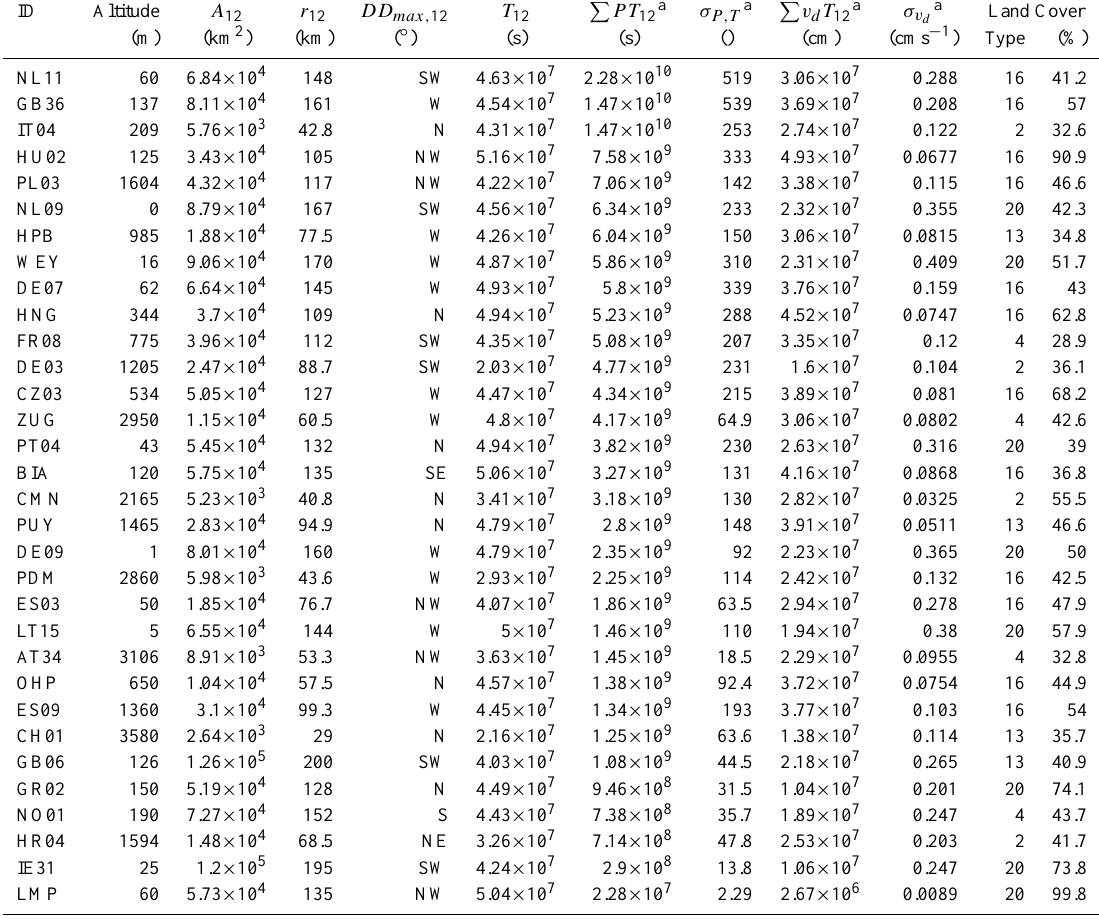
Table 2a. Catchment area parameters for 12h catchment: A 12 total surface area of catchment, r 12 equivalent radius, DD max , 12 main total dry deposition times residence time, σ v standard deviation of dry deposition. The table entries are sorted by population times total d residence